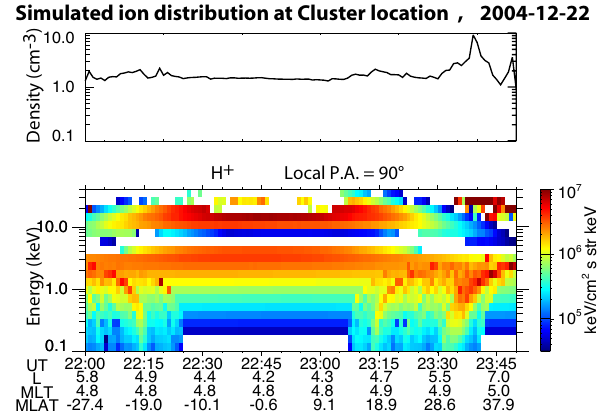
Fig. 6. Number density (upper panel) and energy-time energy flux spectrogram (lower panel) of simulated H + starting from the sum- mation of cold source (Fig. 5) and hot source (Maxwellian with 1keV temperature and 0.5 × 10 6 /m 3 density). The hot source is as- sumed to be constant all the time. The assumed electric field and magnetic field are described in Sect.